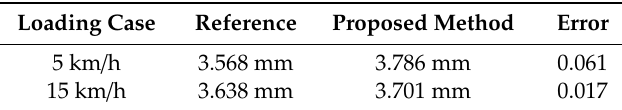
Figure 8. Comparison of maximum displacements at the mid-span point of the bridge: ( a ) truck speed of 5 km / h ( b ) truck speed of 15 km / h. Table 4. Comparison of